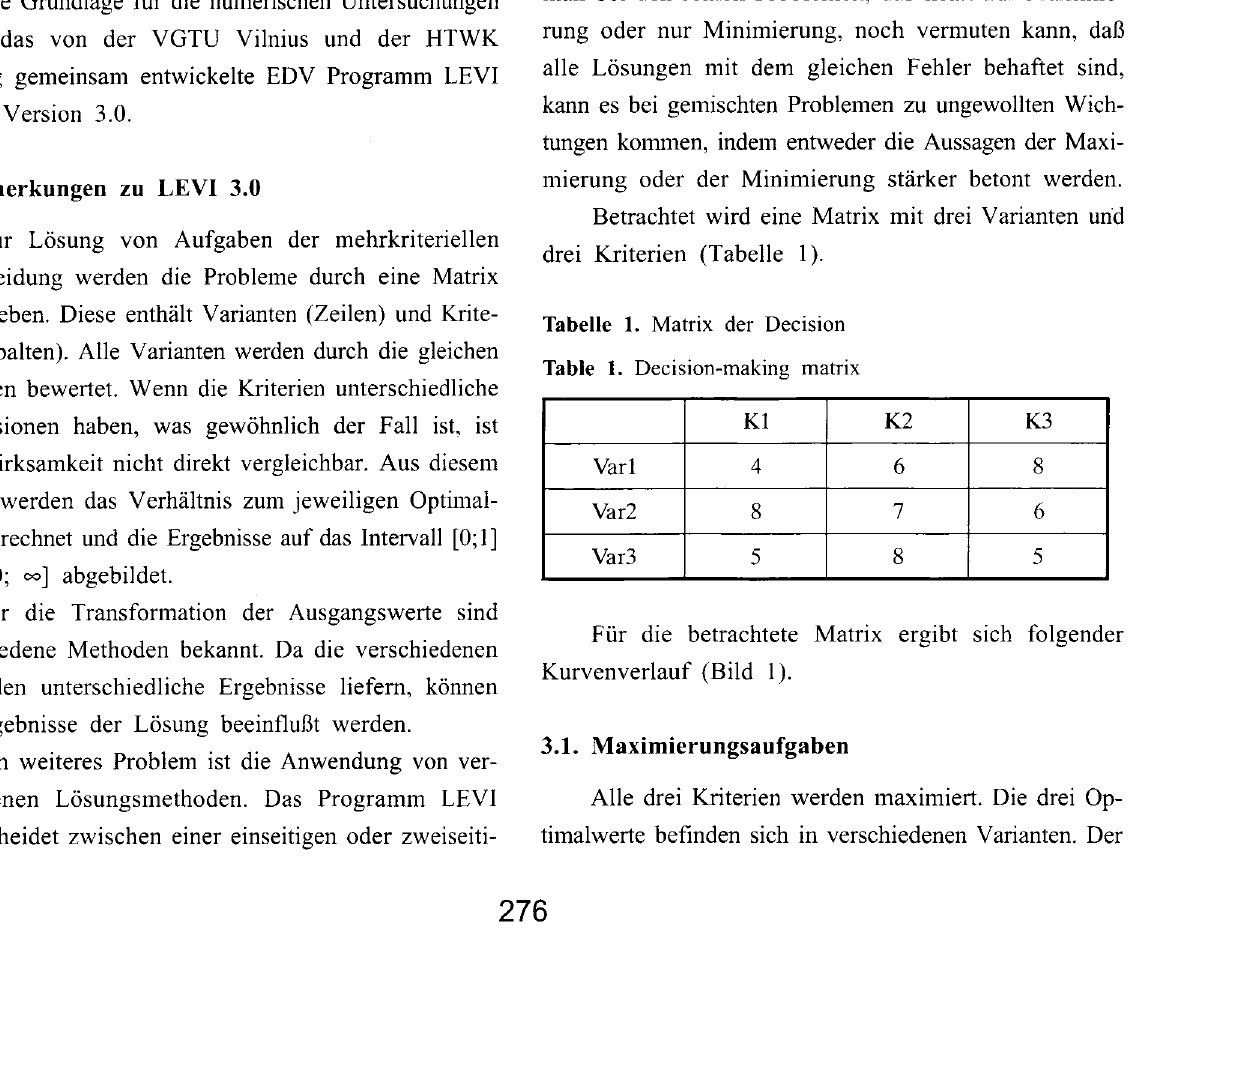
Tabelle 1. Matrix der Decision Table 1. Decision-making